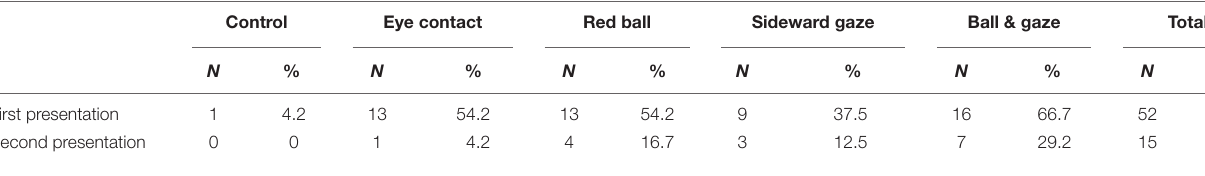
TABLE 1 | Number of deceived participants per experimental